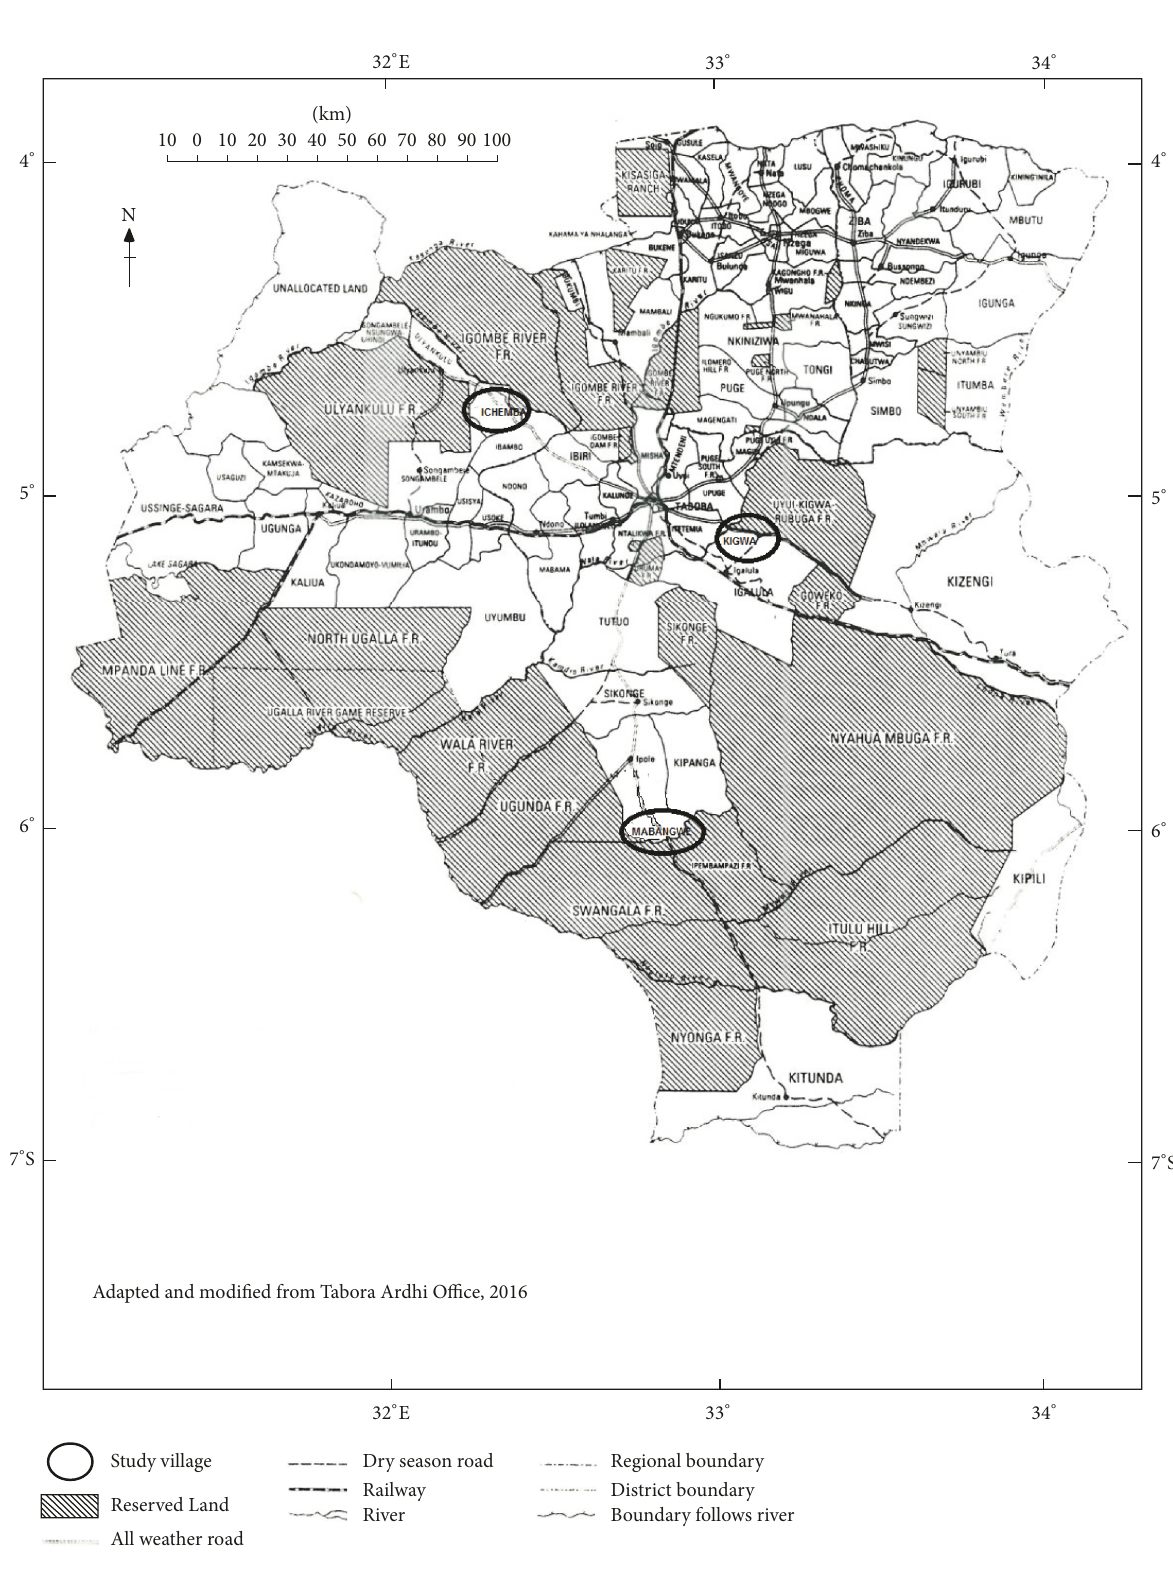
Figure 2: Map of Tabora Region showing study areas. Source: Tabora Lands Office,